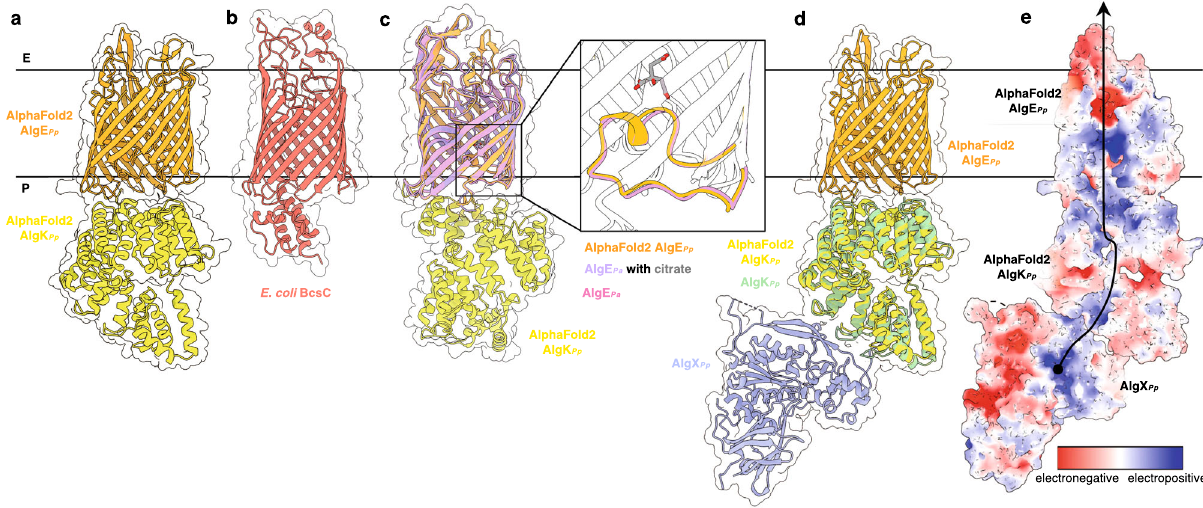
Fig. 6 | Model of the AlgEKX outer membrane alginate modi fi cation and secretion complex. a AlphaFold2 model of the P. putida AlgEK complex (AlgE Pp , orange; AlgK Pp , yellow). b E. coli BcsC structure (PDB: 6TZK) 40 (salmon). c Superimposition of the AlphaFold2 AlgE Pp (orange) with AlgE Pa (pink, PDB: 3RBH) 33 andAlgE Pa (lightpurple)complexedwithcitrate(gray,PDB:4AFK) 22 ,which acts as a mimic of mannuronate/guluronate. The inset highlights the AlgE periplasm-facing T8 loop in a closed state. d Model of the outer